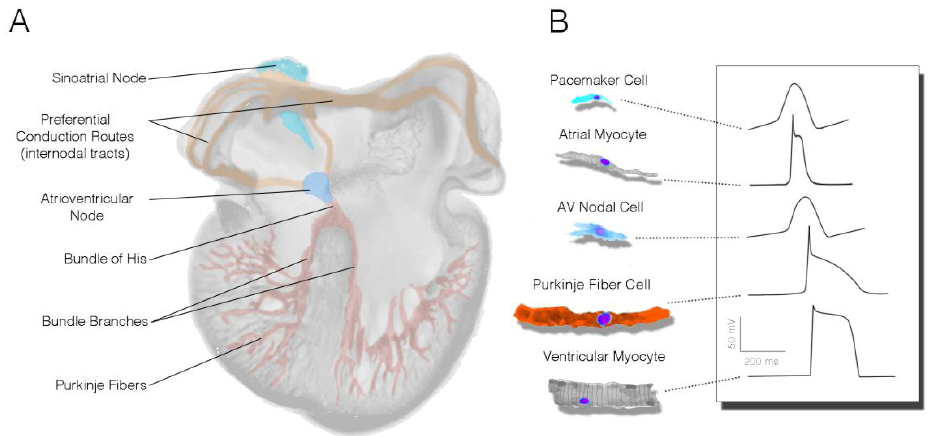
Figure 1. Organization of the mature cardiac conduction system. ( A ) Schematic of a four-chambered heart indicating the relative positions of the specialized subcomponents of the cardiac conduction system; ( B ) Relative cytoarchitecture and action potential characteristics of cells from various conduction system and working myocardial populations.